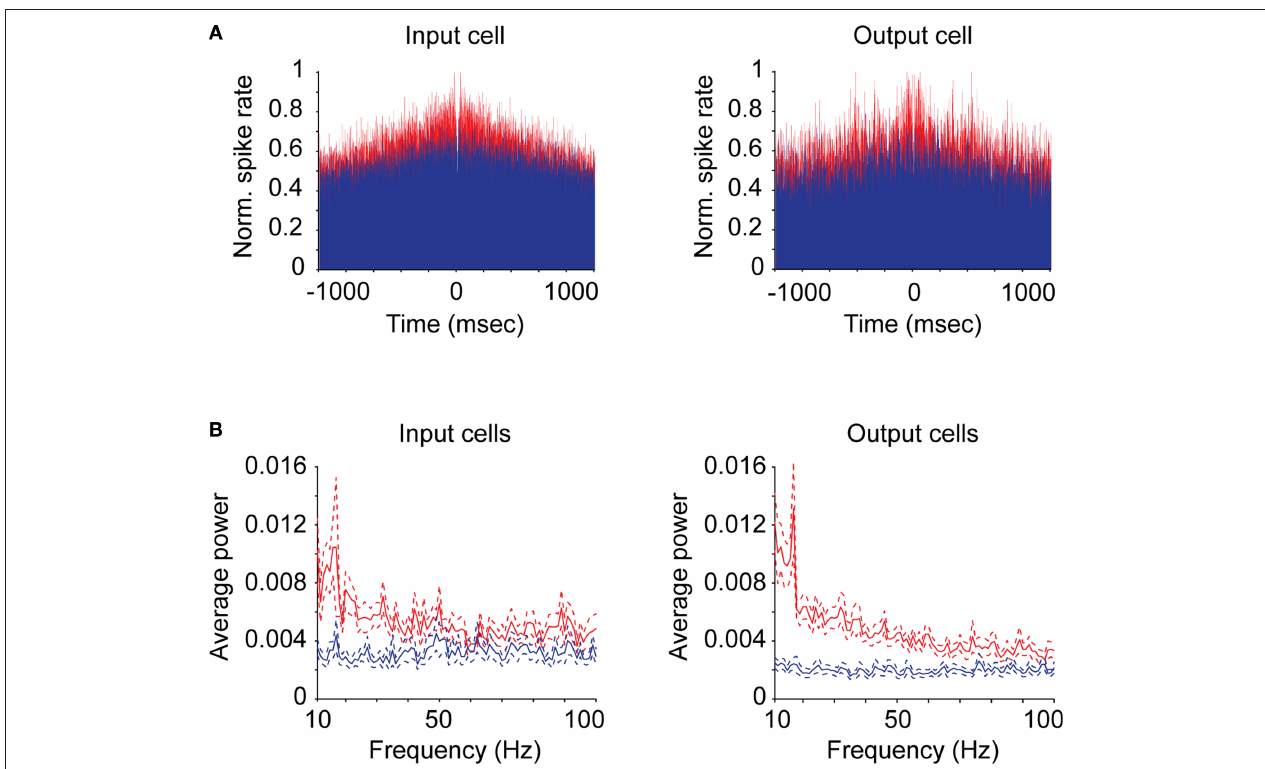
FIGURE 2 | Correlograms and power spectra for input and output neurons. (A) Cumulative autocorrelograms (red) and shuffl e correlograms (blue) for representative individual input (geniculocortical-recipient) and output (corticogeniculate) neurons. (B) Average power spectra between 10 and 100 Hz for all input and output neurons generated from autocorrelograms (red) and shuffl e correlograms (blue). Dashed lines represent standard errors above and below the